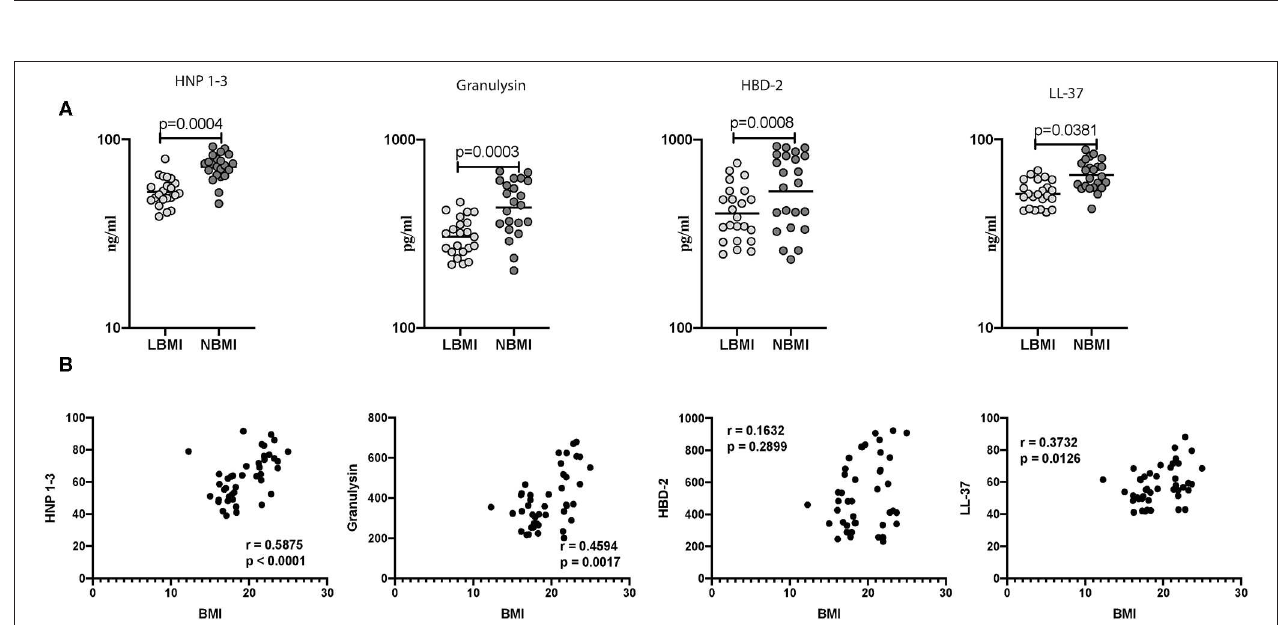
FIGURE 3 | Low BMI is associated with diminished mycobacterial-antigen stimulated levels of HNP1-3, granulysin, HBD-2 and cathelicidin. (A) The mycobacterial-antigen stimulated levels of HNP1-3, granulysin, HBD-2, and cathelicidin (LL37) were measured by ELISA in LTBI-LBMI ( n = 44) and LTBI-NBMI ( n = 44) individuals. The data are depicted as scatter plots and each circle represents a single person. Mann–Whitney U -test with Holms correction for multiple comparisons were done to calculate p -values. (B) Relationship between the levels of HNP1-3, granulysin, HBD-2, and cathelicidin (LL37) and BMI in LTBI individuals. The relationship between the mycobacterial-antigen stimulated levels of HNP1-3 and granulysin, HBD-2 and cathelicidin (LL37) and BMI were examined in all LTBI ( n = 44) individuals. p and r -values were determined by Spearman rank correlation test at 95% confidence intervals.